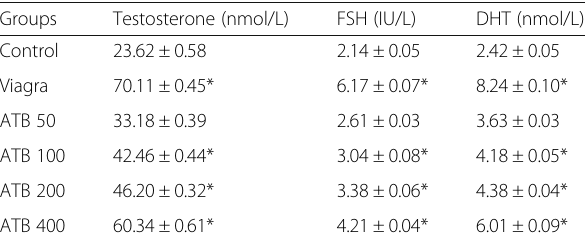
Table 1 Effect of ATB on the level of testicular hormones in the male rats